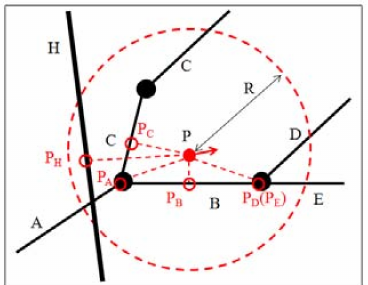
Figure 2. CFs and their spatial relations. The CFs A, B, C, D, and E are urban ordinary roads, and the CFH is an urban elevated road. The point P is the observation point, whose shortest distances to various CFs are denoted by red dashed lines. The candidate points are denoted by red hollow circles. The intersection points among CFs are denoted by black solid circles. The candidate region is denoted by the red dashed circle. The letter R denotes the candidate